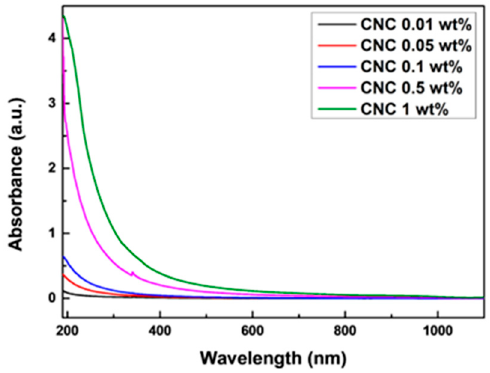
Figure 5. UV–Vis spectra measurement for the dispersion of CNC nanofluids.